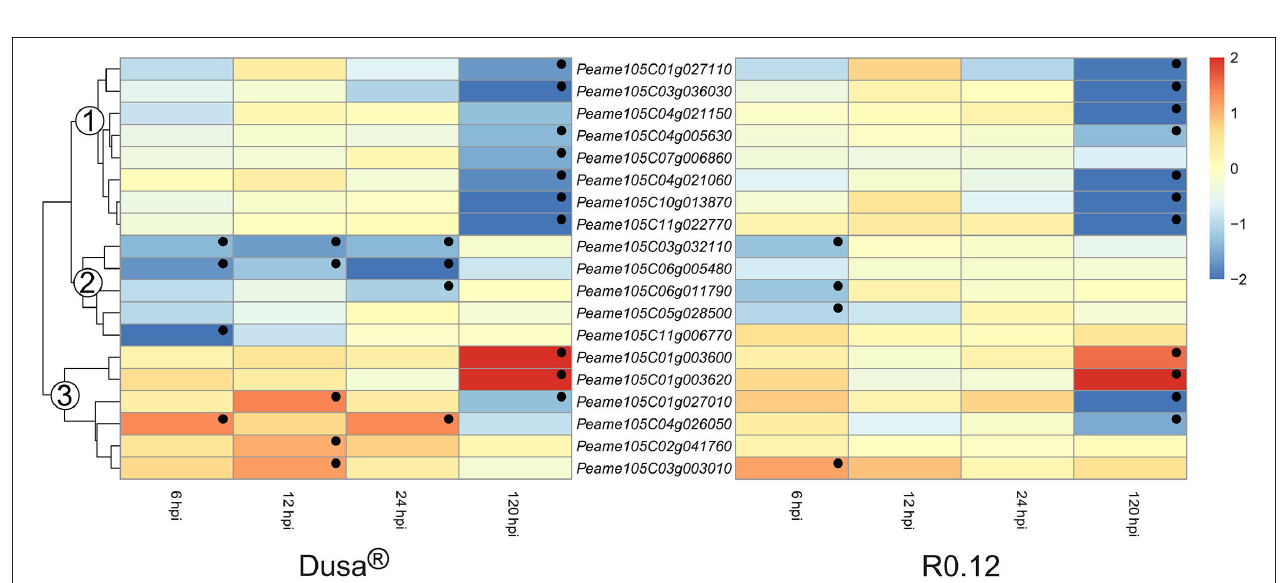
FIGURE 10 | Heatmap and dendrogram illustrating the expression of genes encoding for apoplastic serine proteases in Persea americana following inoculation with Phytophthora cinnamomi. Differentially expressed genes (DEGs) encoding for apoplastic serine proteases from both partially resistant (Dusa ® ) and susceptible (R0.12) P. americana rootstocks are indicated. Differential expression at 6, 12, 24, and 120h post inoculation (hpi), following inoculation with P. cinnamomi , was calculated using mock-inoculated (dH 2 O) sample libraries as the control. Significantly upregulated [log 2 (fold change) > 1, p = 0.05] genes are indicated by a red color, while significantly downregulated [log 2 (fold change) < − 1, p = 0.05] genes are indicated in blue, the intensity of which represents scale. Significant DEGs are indicated with a black dot. The expression of serine protease coding genes was broadly clustered into three groups based on the dendrogram from Dusa ® and were indicated numerically on the dendrogram. Only serine proteases that were differentially expressed in one or more samples and were predicted to localize to the cell membrane or extracellular space are